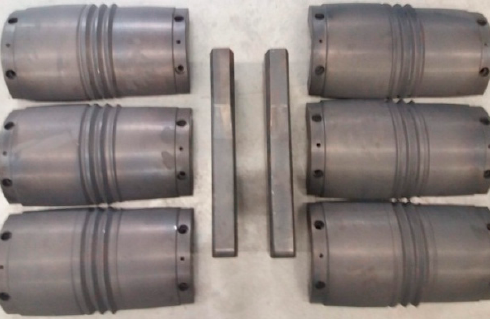
Figure 13. A set of segmented tools with helical passes for rolling rods from scrap rail heads.